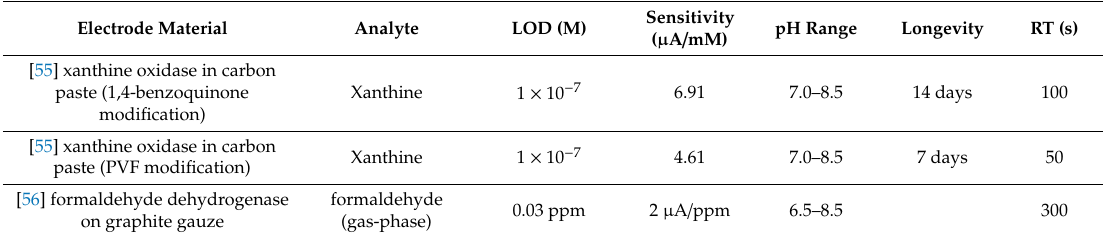
Table 3. Enzyme-based electrodes and their